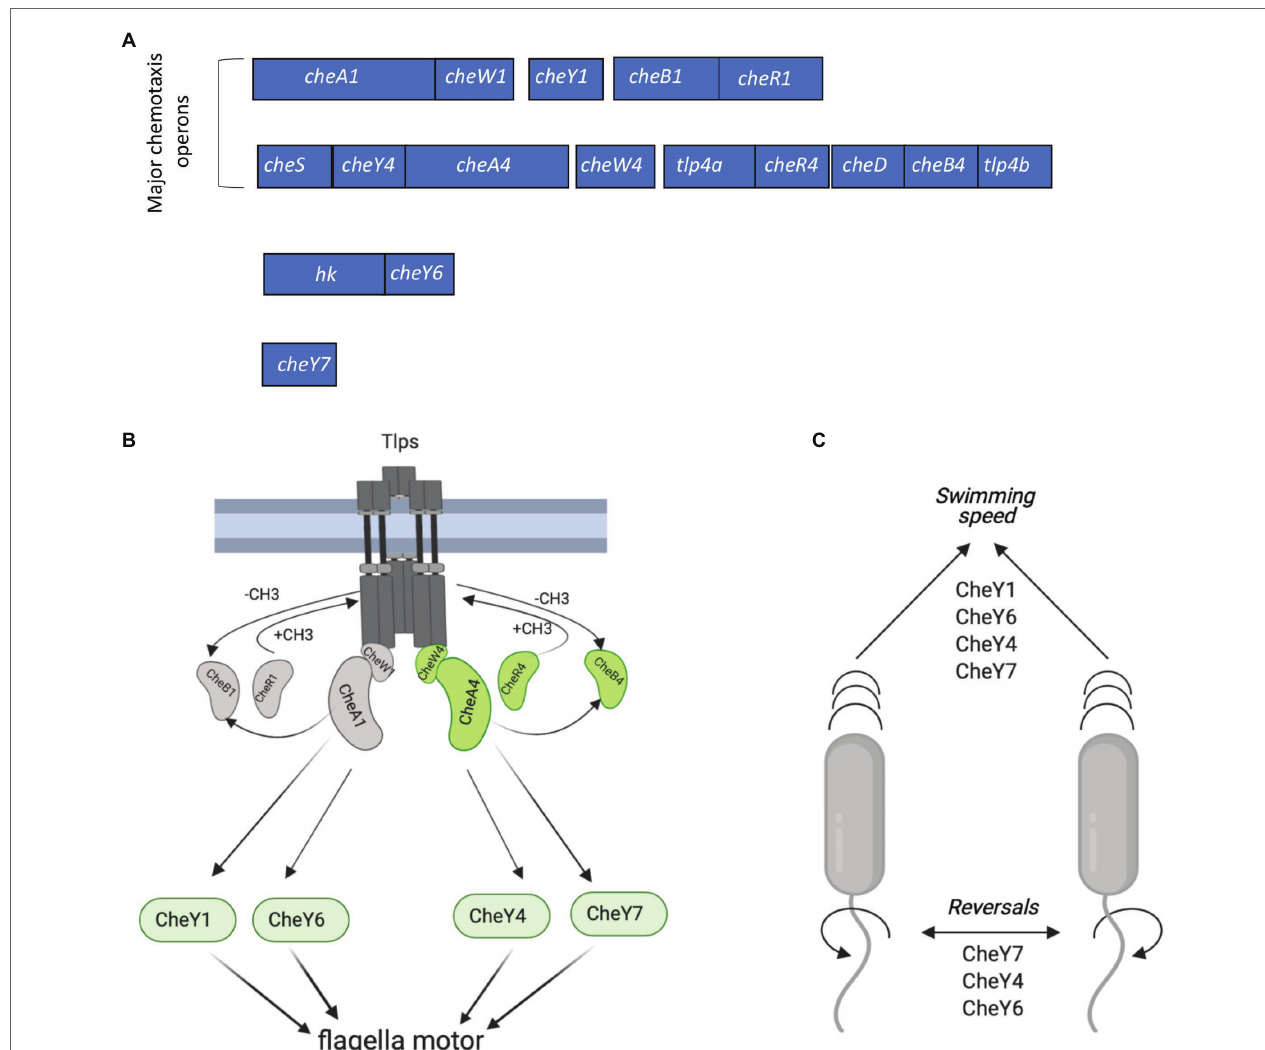
FIGURE 1 | Chemotaxis signaling in Azospirillum brasilense and gene clusters encoding CheY response regulators. (A) Open reading frames (ORFs) are drawn to scale. The chemotaxis-related genes within each cluster were either previously characterized or identified by homology searches. hk, histidine kinase. Response regulators CheY1 and CheY4 are encoded with each of the two major chemotaxis operons ( che1 and che4 ). CheY6 and CheY7 are encoded elsewhere on the genome. (B) Membrane bound chemotaxis receptors (Tlps) are organized in signaling arrays with mixed base plates consisting of CheW1/CheA1 and CheW4/ CheA4 proteins. Environmental signals (repellent or chemoattractant) received by Tlps modulate changes in their conformation and autophosphorylation activity of CheA1 and/or CheA4, which ultimately affect the phosphorylation states of flagellar-motor switching response regulators (CheYs). The activity of Tlps is switched off by the addition of the methyl groups chemoreceptor-specific methyltransferase (CheR1 and CheR4) and switched on by the removal of the methyl groups by the chemoreceptor-specific methylesterase, CheB1 and CheB4. Activity of CheB1 and CheB4 depends on autophosphorylation of CheA1 and CheA4. (C) Scheme depicting the role of CheYs in the modification of the swimming speed and reversals. Figures in panels (B,C) were created using